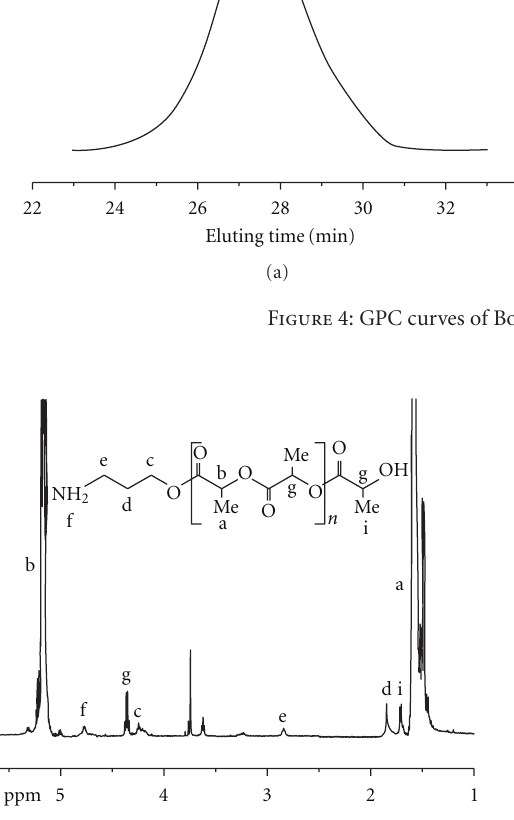
Figure 5: 1 H NMR spectra of NH 2 -PLLA in CDCl 3 .